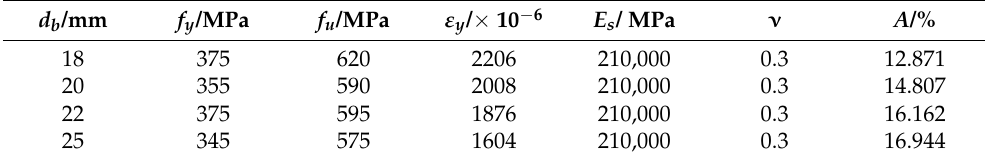
Table 3. Measured mechanical properties of